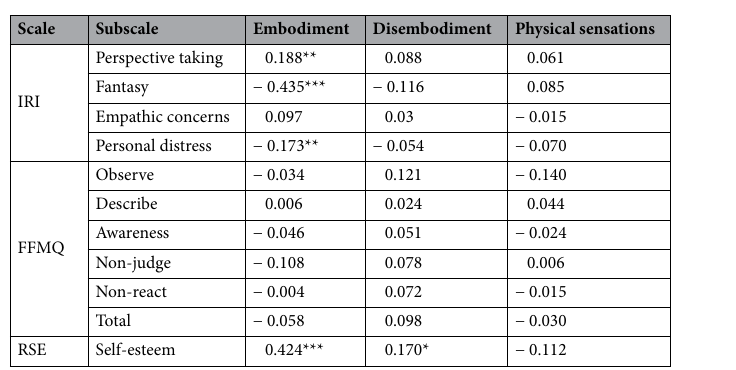
Figure 6. Scale scores are depicted in the graphs and reported in the associated table in the lower part of the figure. The graphs are boxplots where the thick lines represent the medians, the boxes represent the interquartile ranges (25°–75°), and the whiskers represent minimum and maximum. The associated table reports the descriptive statistics for the synchronous and asynchronous conditions, and the paired samples t test results of the Synchronous Vs Asynchronous match. Cohen’s d z was used to report the effect size.